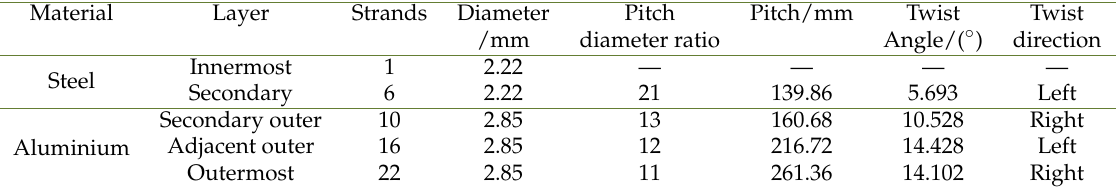
Table 2. Structural parameters of ACSR